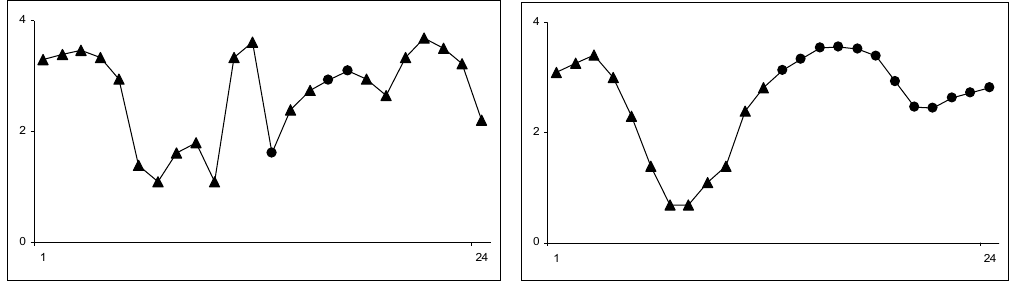
Figure 4 – Actual (triangles) and fitted (circles) values of days 7 (a) and 161